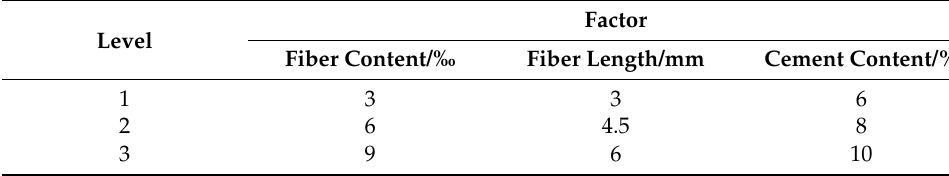
Table 3. Orthogonal test factor levels.